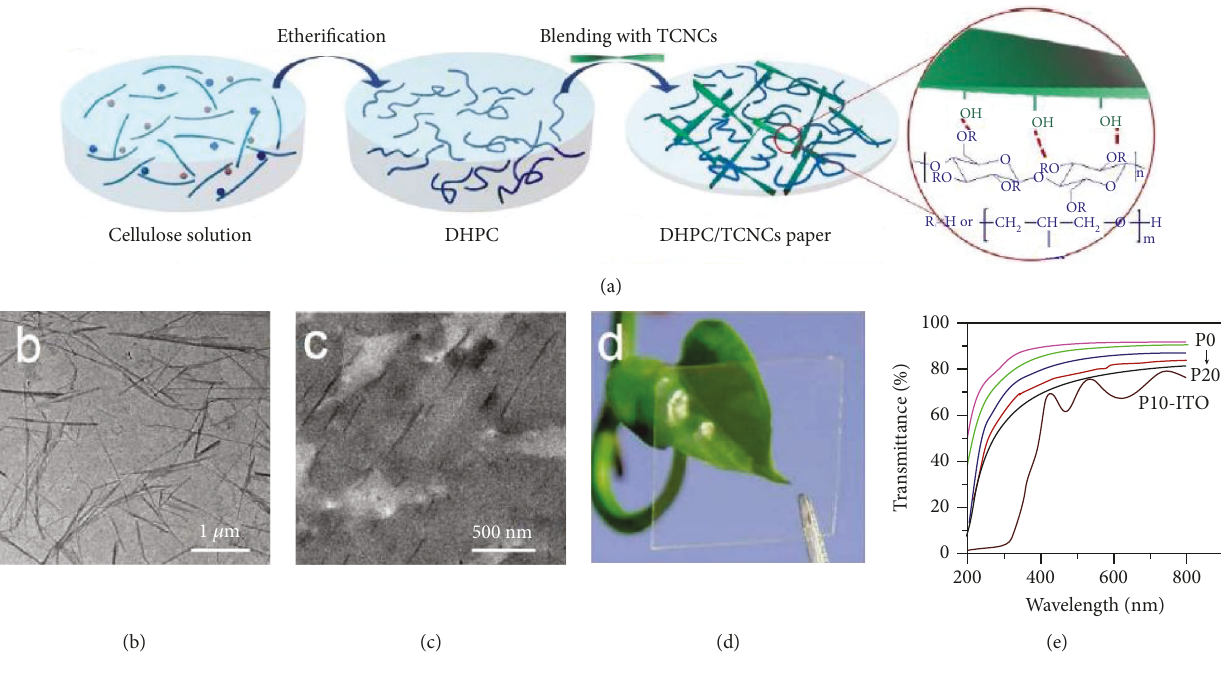
Figure 14: (a) Fabrication of cellulose-based nanocomposite papers: etheri fi cation of cellulose to synthesize DHPC, followed by blending with tunicate CNCs and fi ltering. The cellulose ether interacts with the cellulose nanocrystal surface by accepting H-bonds. (b) TEM image of CNCs (scale bar: 1 μ m); (c) TEM image of composite fi lms (scale bar: 500nm); (d) photograph of the composite fi lm and (e) optical transmittance in the UV-Vis region of nanocomposite papers at di ff erent DHPC content. Reproduced from reference [12] with permission from the American Chemical